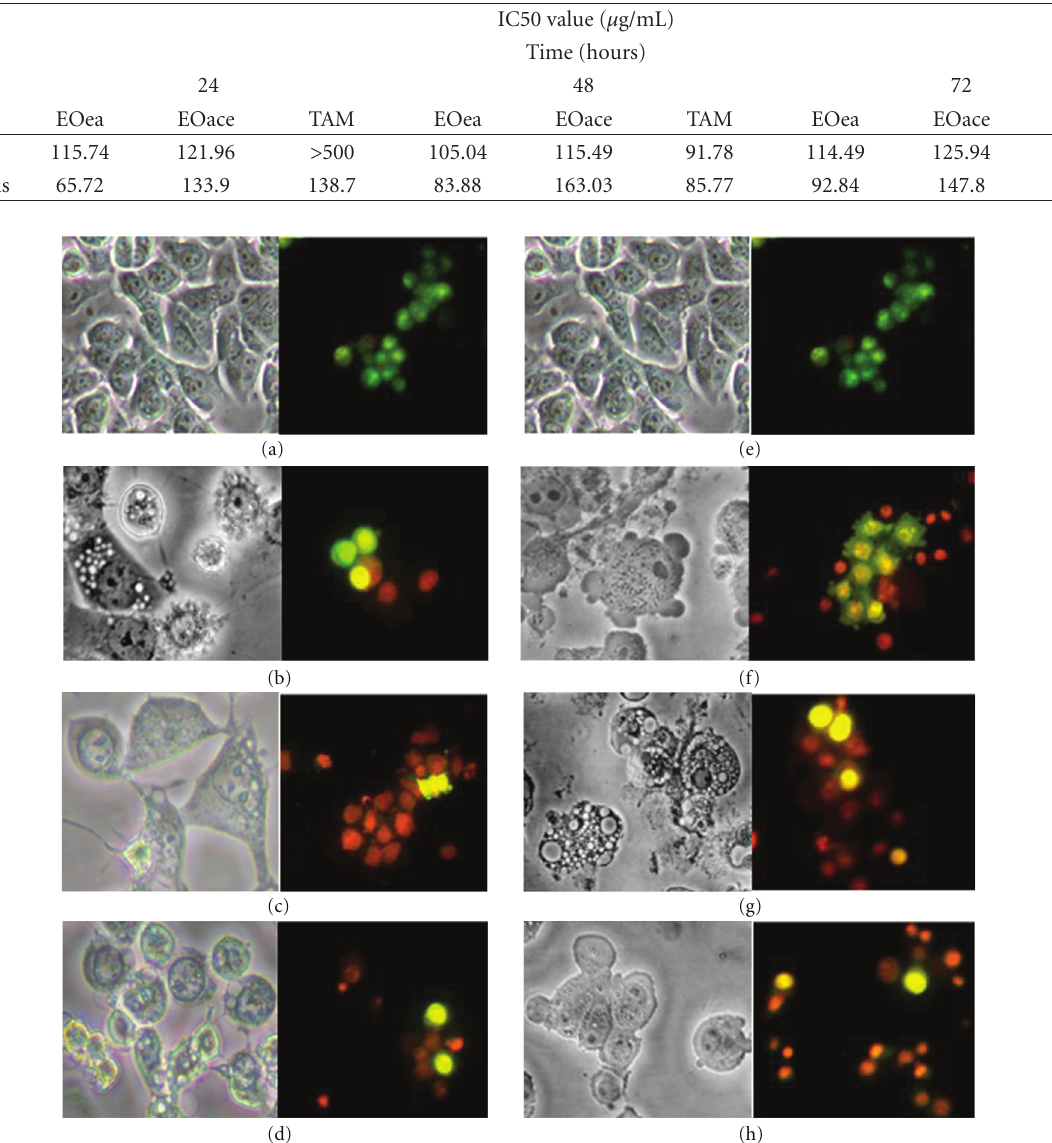
Figure 2: Phase contrast and fluorescent microscopic analysis of MCF-7 cells treated with EOea and EOace at di ff erent time periods. (a) and (e) untreated MCF-7 cells, (b), (c), (d) MCF-7 cells treated with EOea at 24, 48, and 72 hours, (f), (g), (h) cells treated with EOace at 24, 48, and 72